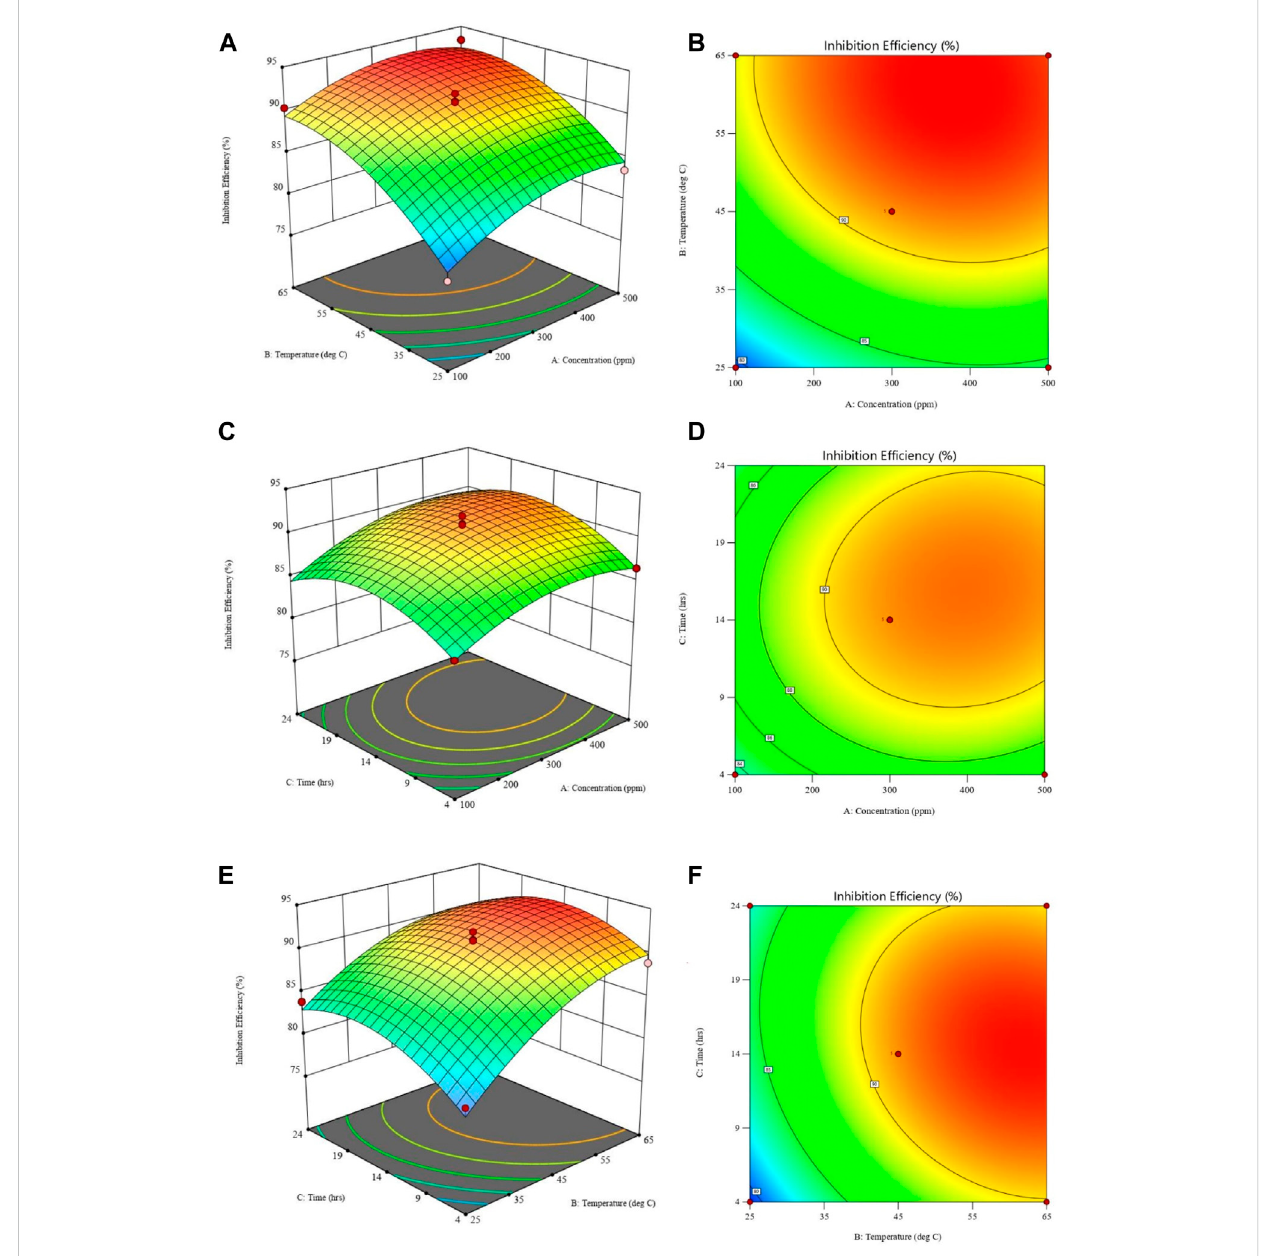
FIGURE 11 Response surface plots (left) and contour plots (right) for inhibition ef fi ciency against: (A,B) temperature and concentration; (C,D) time and concentration; (E,F) time and temperature.